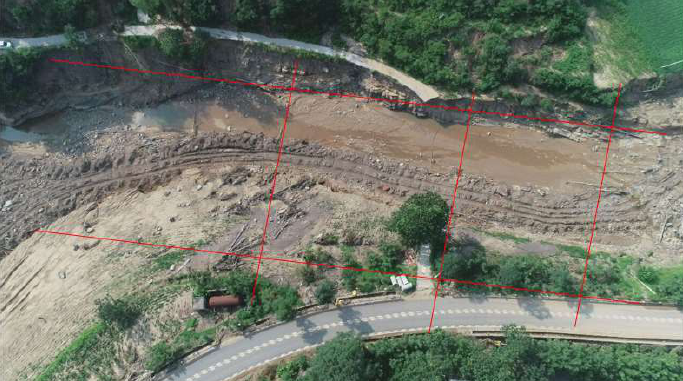
Figure 6. A real shot of the survey section after the flood.